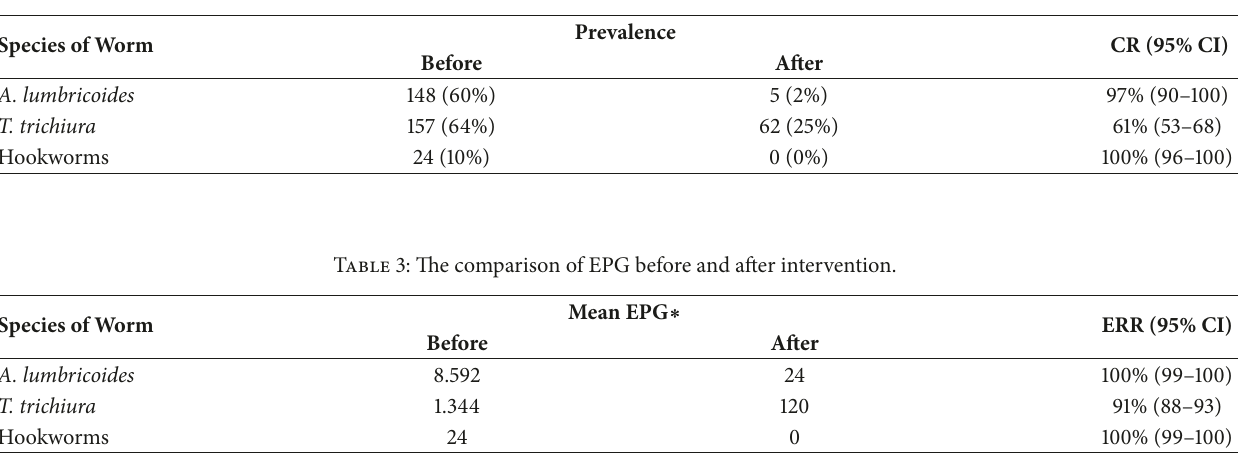
Table 2: The prevalence of STH and cure rate after intervention.